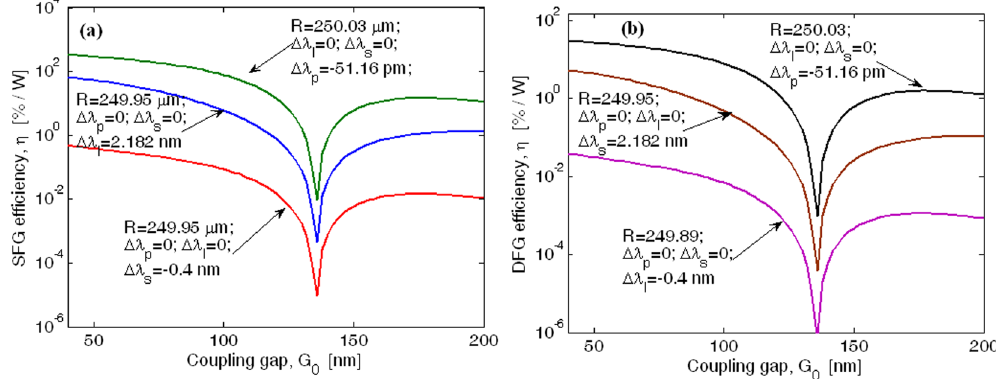
Figure 12. EFIM efficiency as a function of the coupling gap, for different resonance mismatch conditions. ( a ) SFG parametric process. ( b ) DFG parametric process.